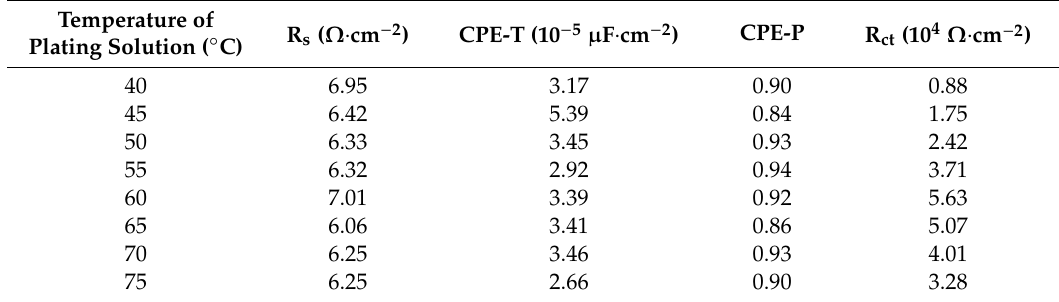
Figure 14. E ff ect of temperature of plating solution on electrochemical impedance spectra of Ni–Co–P alloy coatings in artificial seawater: ( a ) Nyquist; ( b ) Bode. Table 9. Impedance spectrum fitting value of Ni–Co–P alloy coatings at di ff erent temperatures of plating solution obtained from the Figure